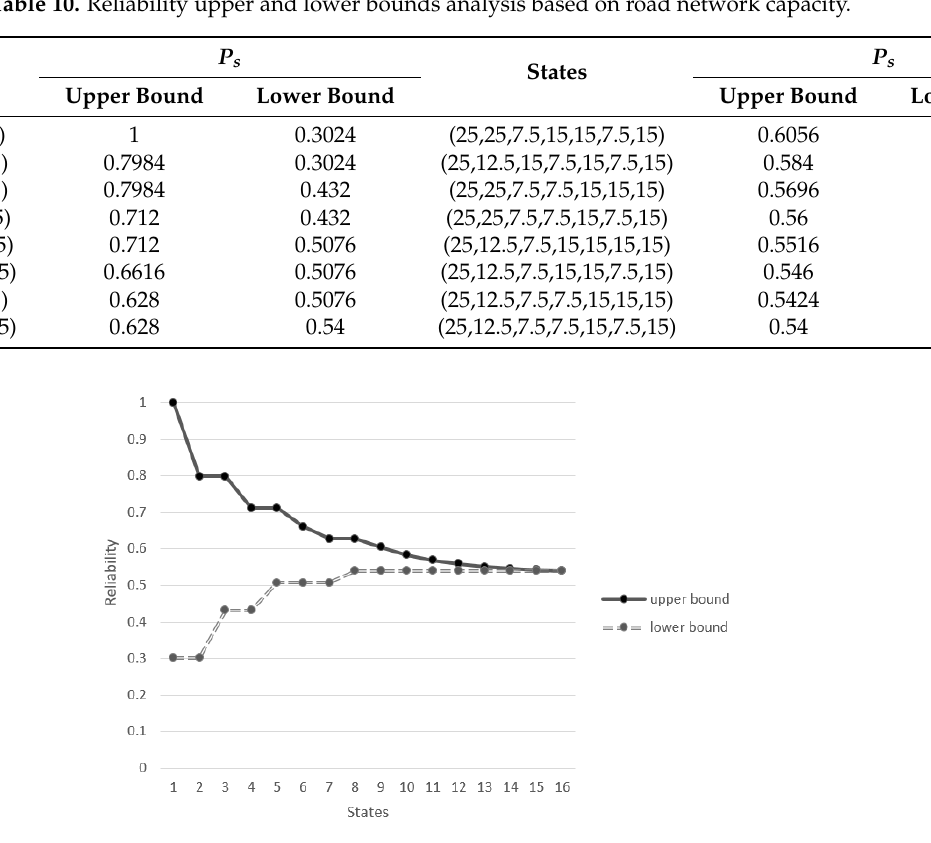
Figure 4. Reliability upper and lower bounds analysis based on road network capacity. Because the results of traffic flow assignment of traditional model do not conform to the law of reality, and the travel time acceptability is not considered, so the improved model allocation results are more